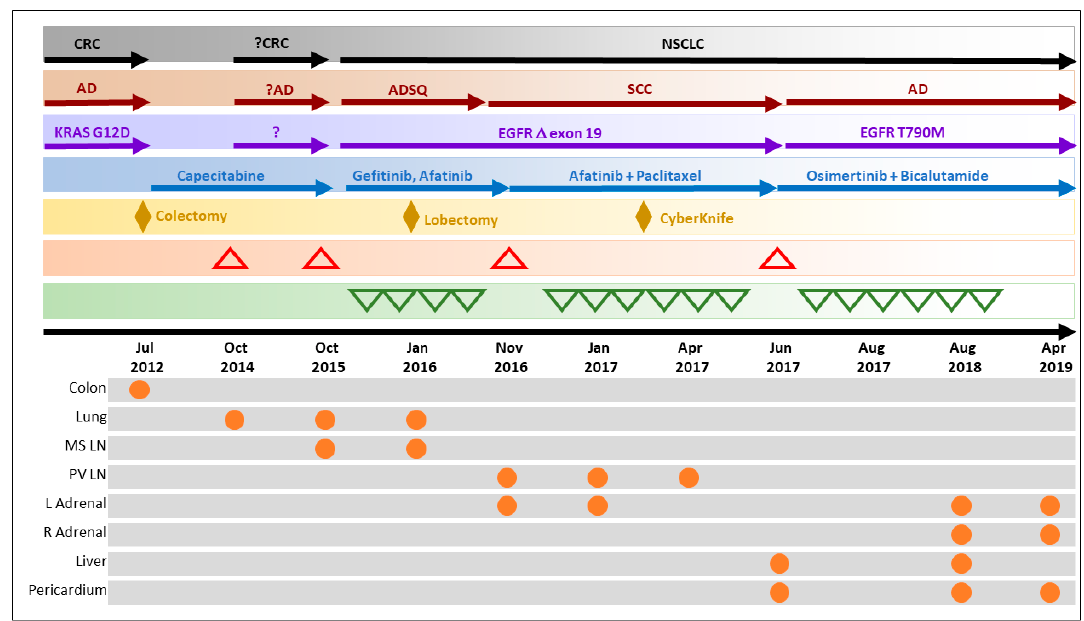
Figure 2. Timeline of events. CRC: colorectal cancer; NSCLC: non-small cell lung cancer; AD: adenocarcinoma; ADSQ: adenosquamous carcinoma; SCC: squamous cell carcinoma; (cid:169) : locoregional treatment; (cid:52) : progression / recurrence; (cid:53) : treatment response / regression; (cid:8) presence of malignant mass at various sites; MS LN: mediastinal lymph node; PV LN: prevascular lymph node; L Adrenal: left adrenal; R Adrenal: right adrenal.